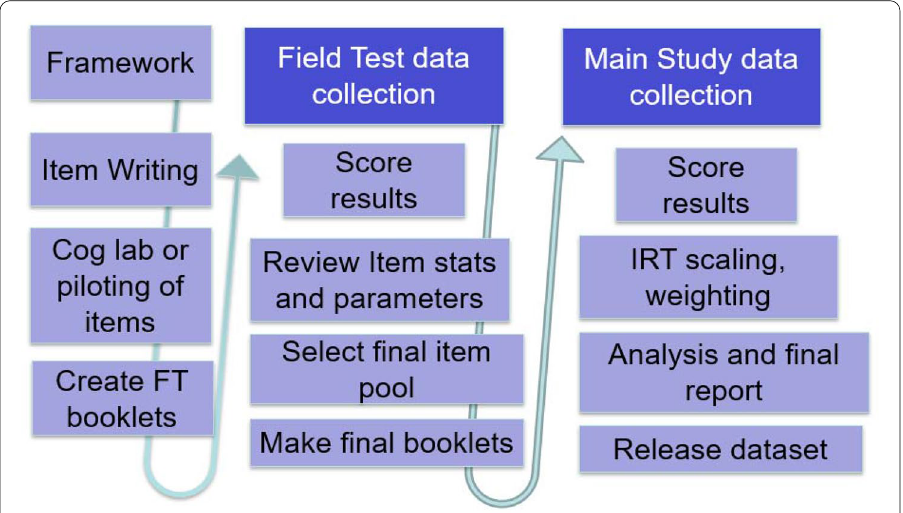
Fig. 3 Assessment system processes before DBA. Graphical representation of an assessment system’s processes, from test development through system operationalization, before DBA. Author’s own